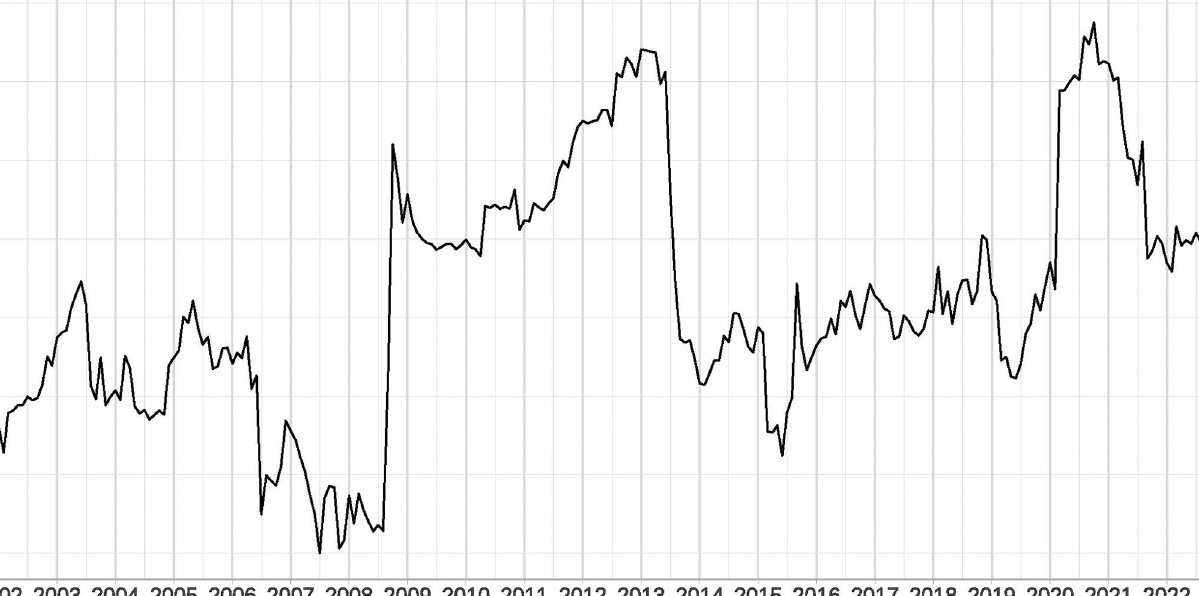
PLOS ONE | https://doi.org/10.1371/journal.pone.0279729 January 26,